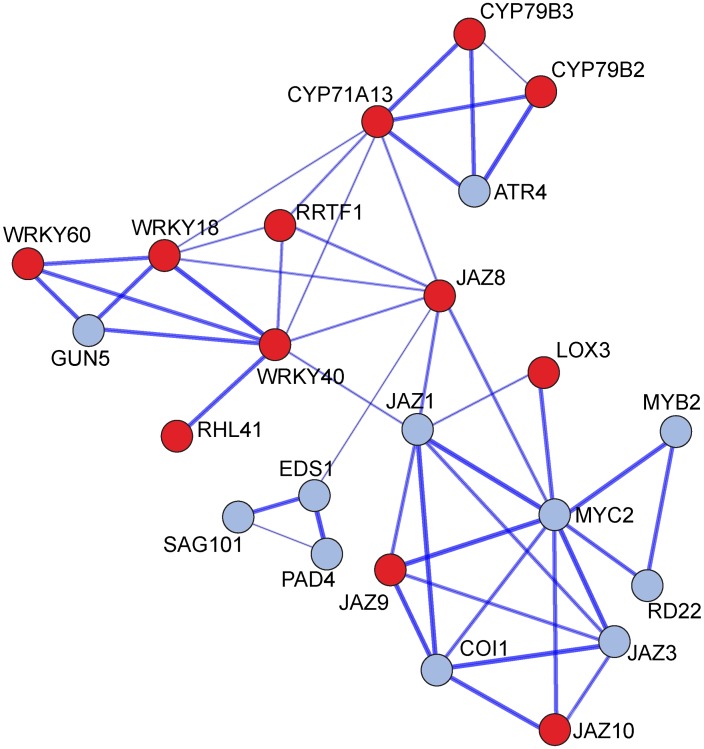
JAZ8 network based on co-expression analysis and data base search.STRING version 9.0 was used to query JAZ8 (AT1G30135) gene. In the resulting network, the expression of each of the gene was monitored by qPCR 24 hpi by T. asperelloides. Red- gene that show significant increased expression (P<0.05; t test), grey- non significant change (P>0.05; t test).